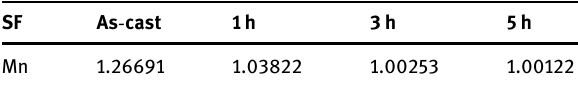
Table 2: Segregation factor of Mn at different times SF As -